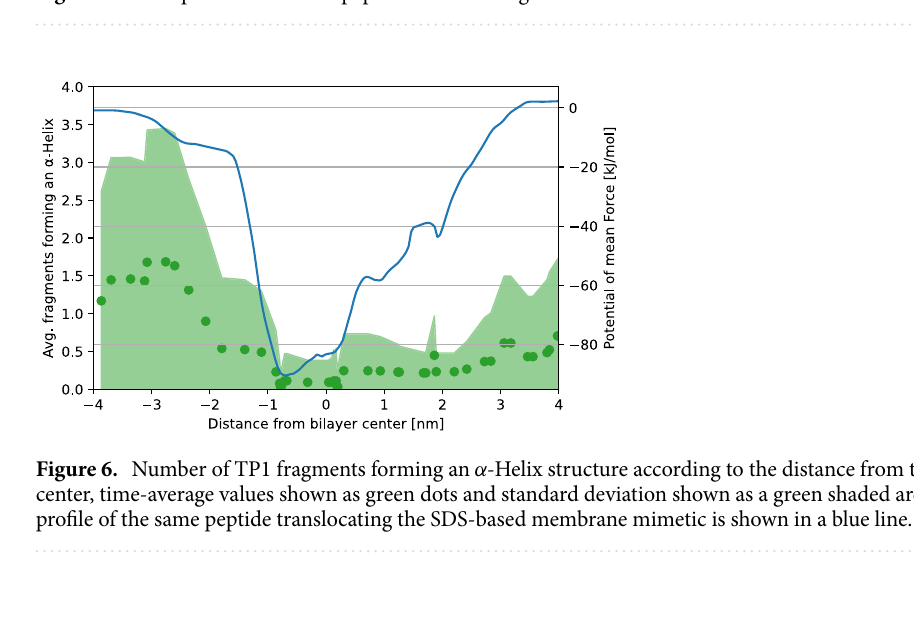
Figure 5. PMF profile of the TP1 peptide translocating a SDS-based membrane mimetic.